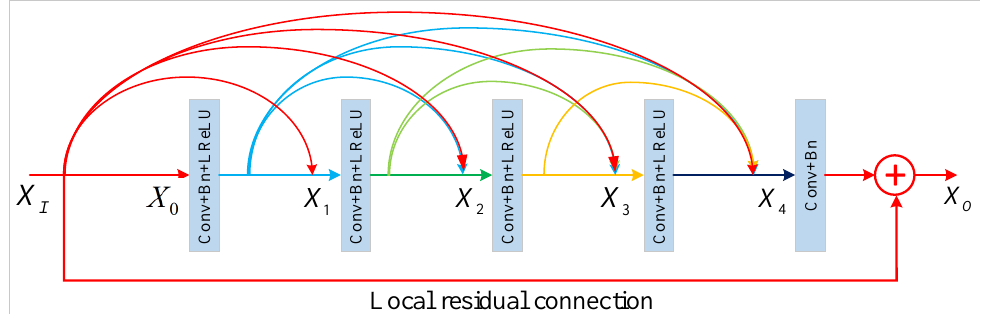
Figure 2. Detailed structure of local residual dense block.